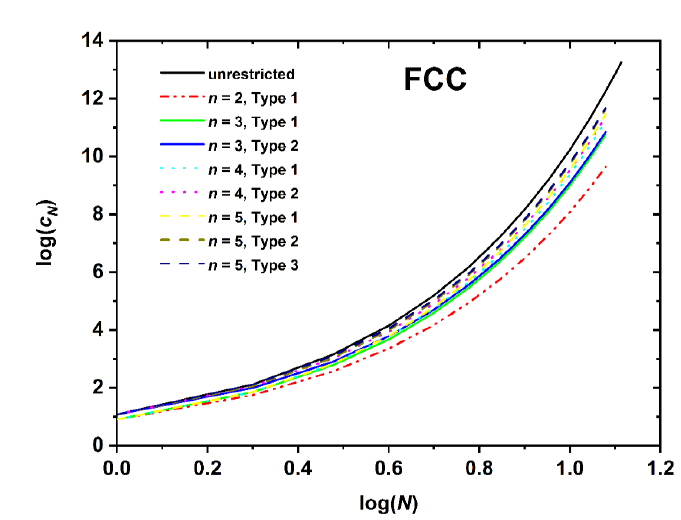
Figure 7. Logarithm of the number of distinct SAWs, c N , versus the logarithm of the number of SAW steps, N , as obtained from direct enumeration on the FCC lattice under plate-like confinement.